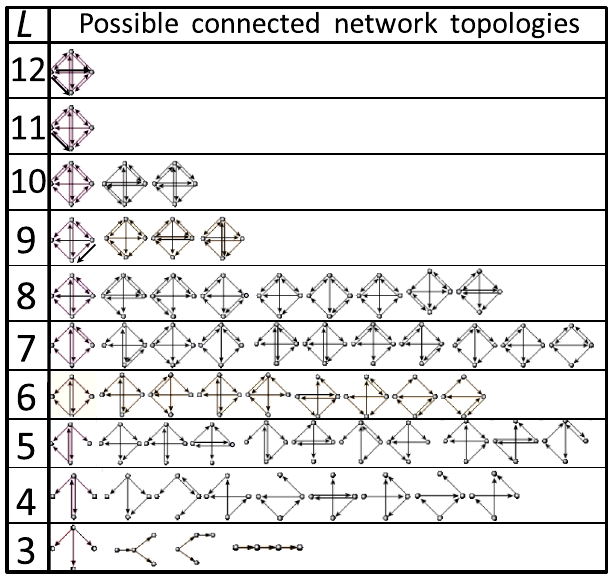
FIG. 4. List of possible connected directed four-node networks [65] with different numbers of links ( L ).